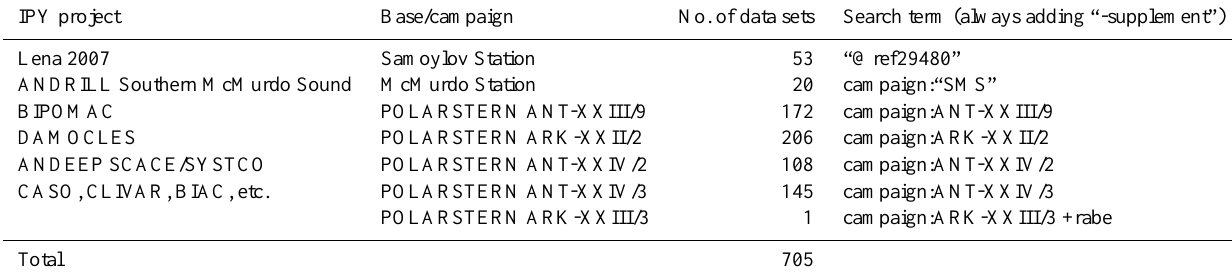
Table 2. Additional IPY-2007–2008-related data sets in PANGAEA from ongoing polar research activities (access date: 7 May 2015). IPY